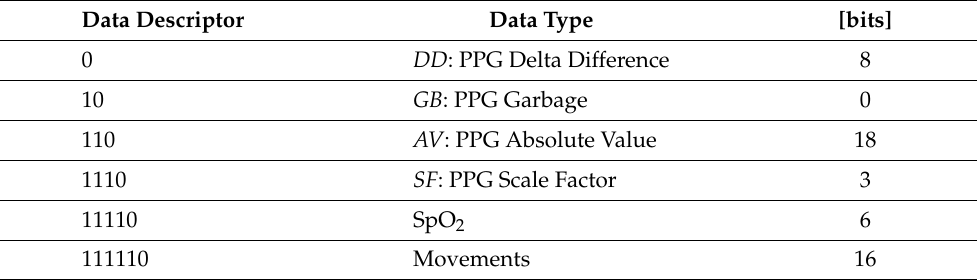
Table 1. List of data descriptors.